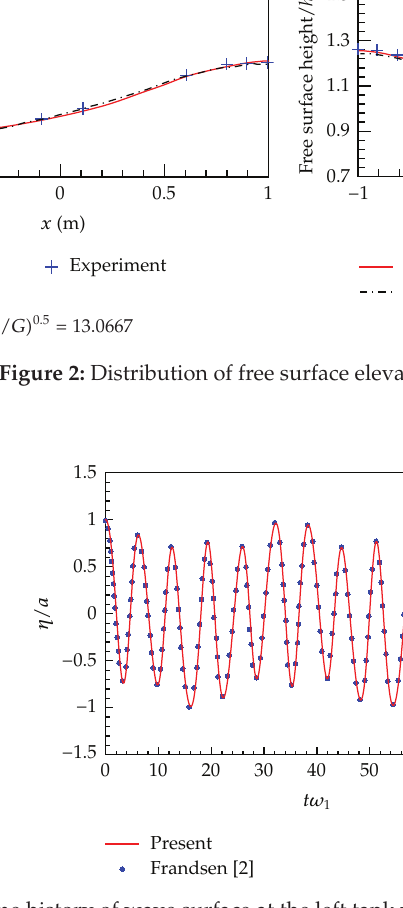
Figure 3: Time history of wave surface at the left tank wall due to vertical excitation.